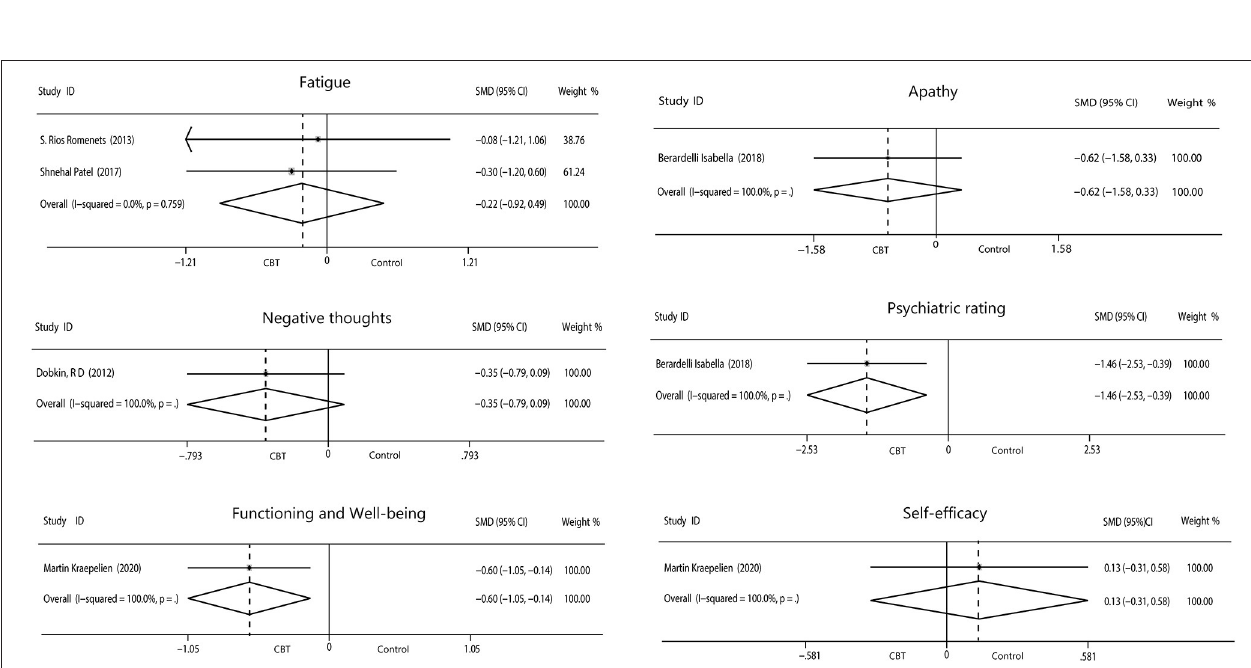
Frontiers in Psychiatry |